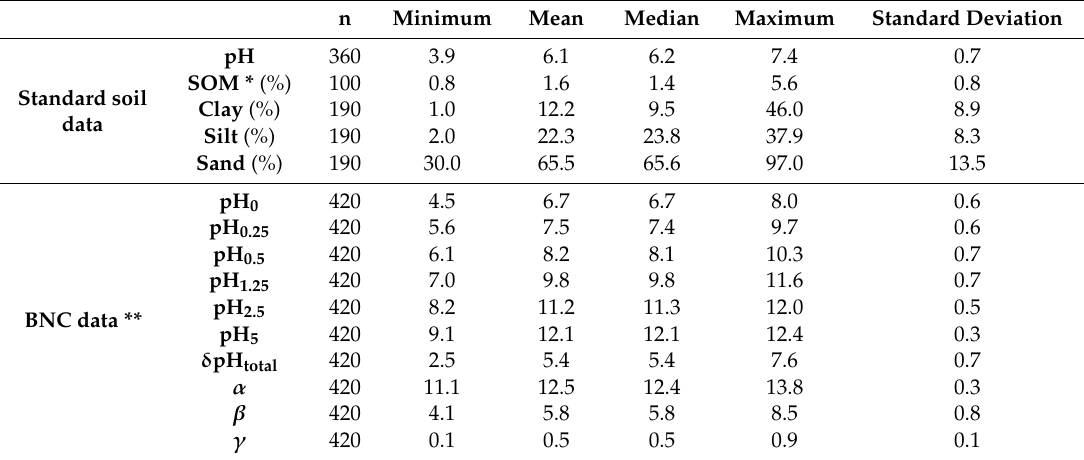
Table 2. Descriptive statistics of the laboratory results of reference soil samples as well as of the base neutralizing capacity (BNC)